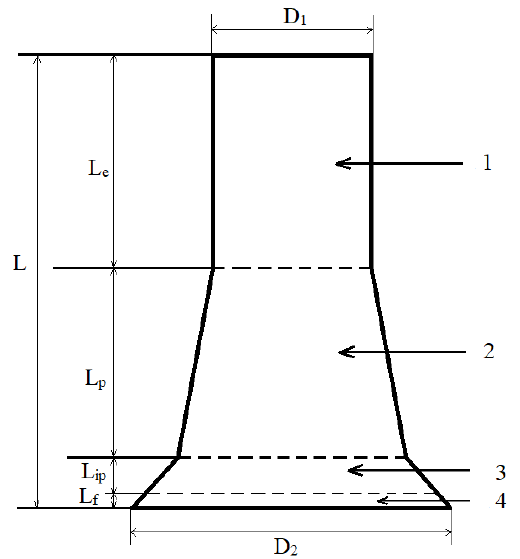
Figure 4. Averaged microhardness distribution of the copper specimen along line C ( a ) and C1 ( b ) at the impact velocity of 316 m/s.